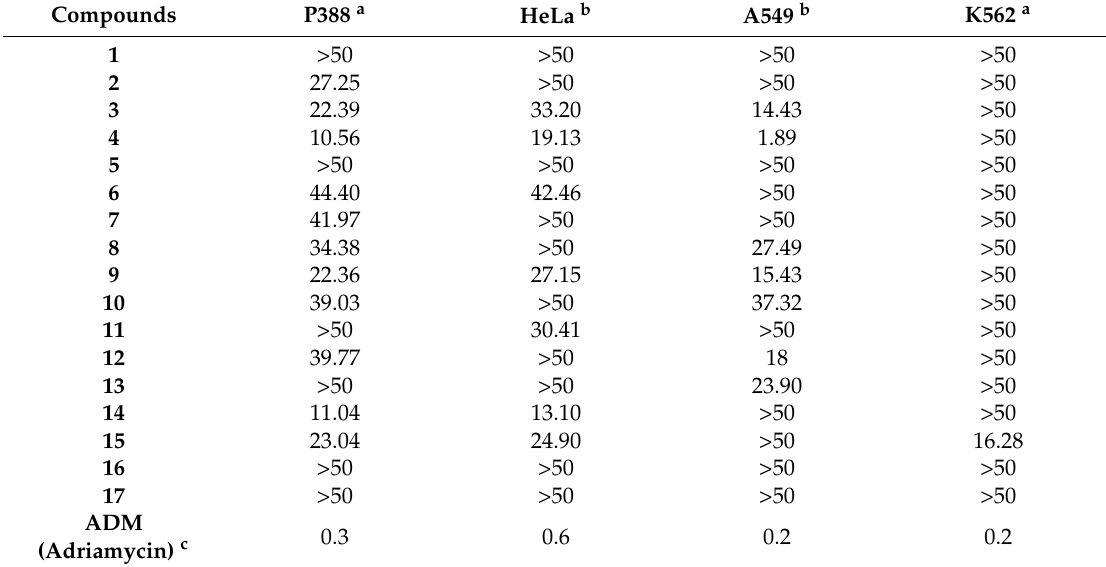
Table 3. Cytotoxic activities of compounds 1 – 17 (IC 50 , µ